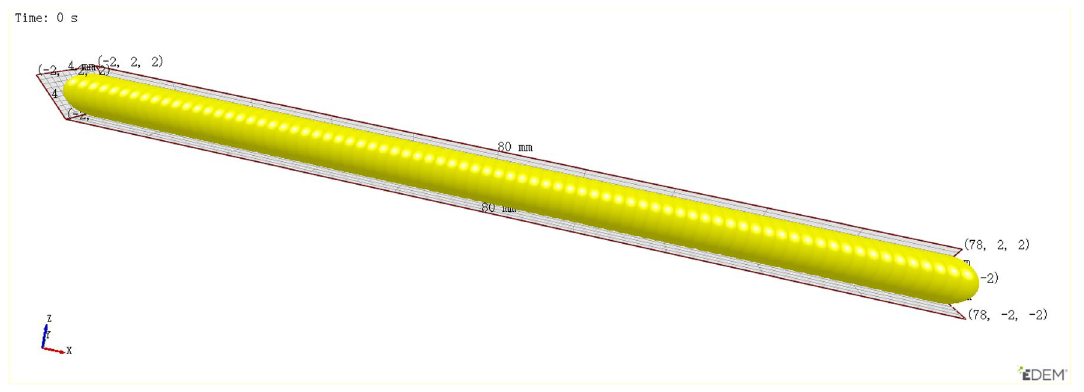
Figure 6. Straw discrete element